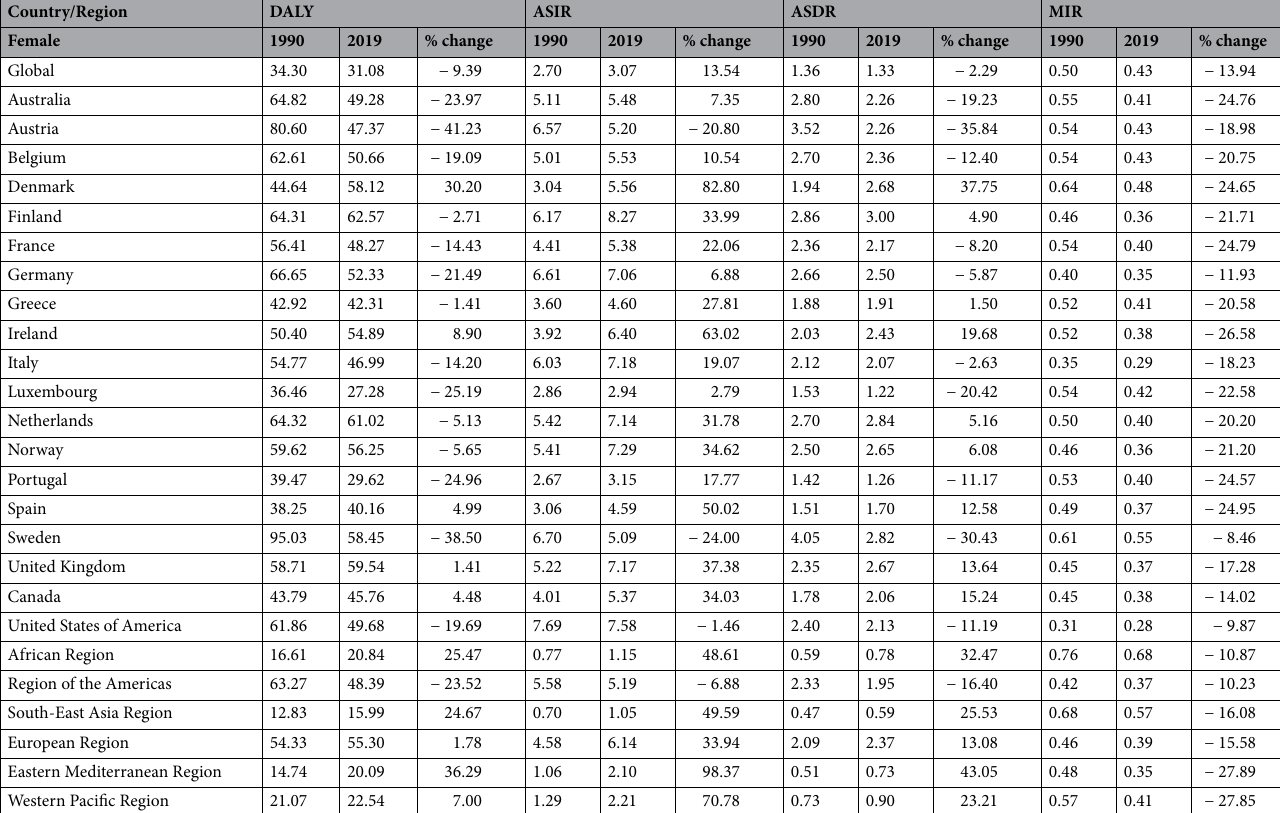
Table 1. 1990 and 2019 female age-standardized mortality rates (ASMRs), age-standardized incidence rates (ASIRs), mortality-to-incidence ratios (MIR), and disability-adjusted life years (DALYs), with